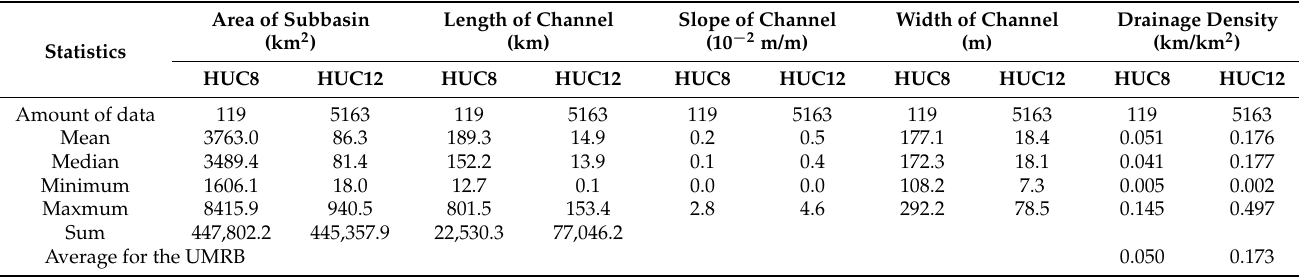
Table 5. Area of subbasin and physical characteristics of the channel in different delineation scenarios.